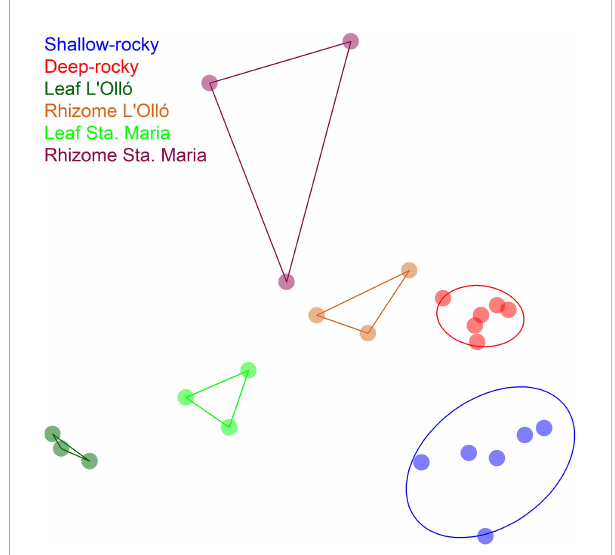
FIGURE 4 Non-metric multidimensional scaling representation of the samples using the Bray-Curtis distance. Hull lines group the samples of leaves and rhizomes of the two meadows studied. Ellipses are 95% con fi dence intervals around the centroids of the rocky reef samples. Stress of the con fi guration: